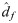
Behaviors of the apparent distance exponent γvw according to the origin and destination populations.We estimate the values of the apparent distance exponent γvw, defined by Eq (24), from the numerical curves of the rescaled travel probability shown in Fig 3 for the values of β = 1.5 (a) and 3 (b), respectively. These values (symbols) are compared to analytic values for the limiting cases, i.e., γ = 2α for mi, mj ≪ sij and γ = α for mi ≪ sij ≪ mj, which are plotted by black dashed lines with gray shadows denoting γ ± σγ. Here σγ is determined using the standard deviation of the estimated d^f.